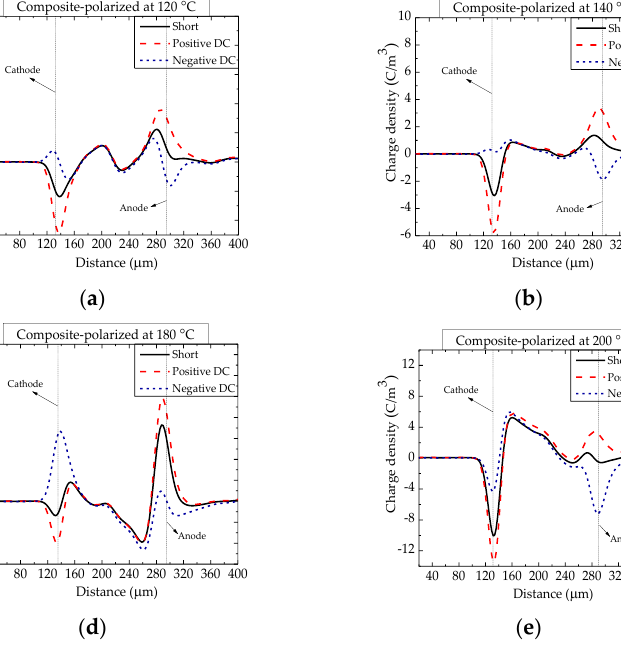
Figure 5. Space charge distribution in epoxy/nano − SiO 2 /micro − BN composite polarized at temper- atures between 120 and 200 °C. ( a ) 120 °C; ( b ) 140 °C; ( c ) 160 °C; ( d ) 180 °C and ( e ) 200 °C. Figure 6 shows the ion density of epoxy resin and the epoxy/nano − SiO 2 /micro − BN composite as a function of temperature from 40 to 200 °C. Among them, the ion density of the composite remains below 10 C/m 3 all the time. However, the accumulated ionic space charges in epoxy resin are greater than those in the epoxy composite above 100 °C. Therefore, SiO 2 – BN fillers can significantly inhibit ion transport and accumulation in the epoxy/nano − SiO 2 /micro − BN composite.